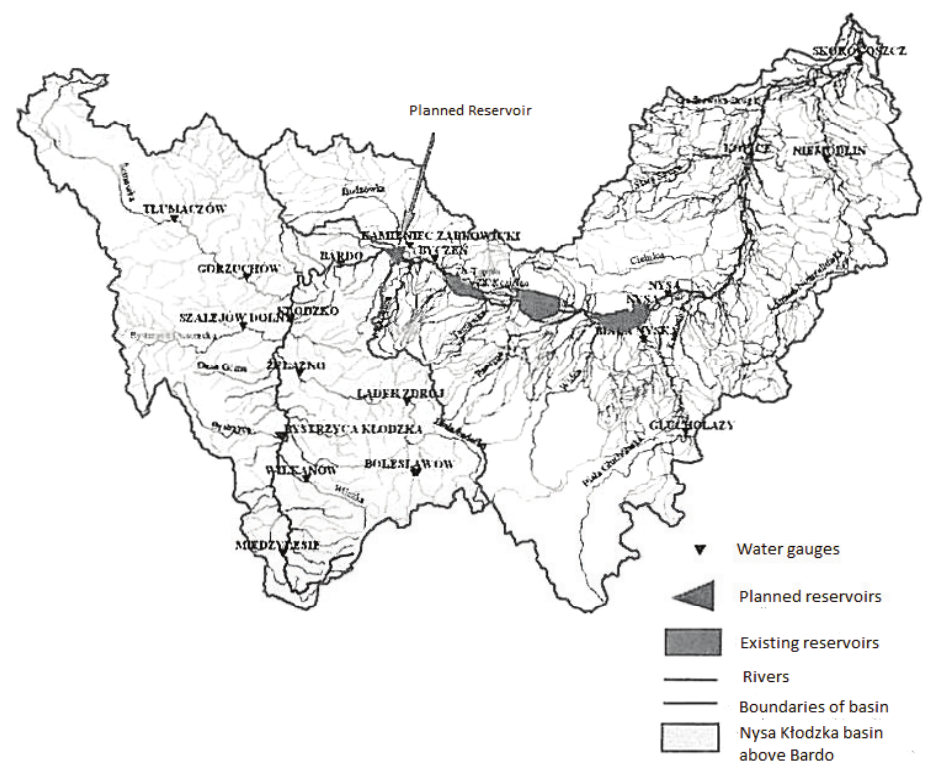
Fig. 1. The location of the planned reservoir and the Nysa Kłodzka basin according to paper